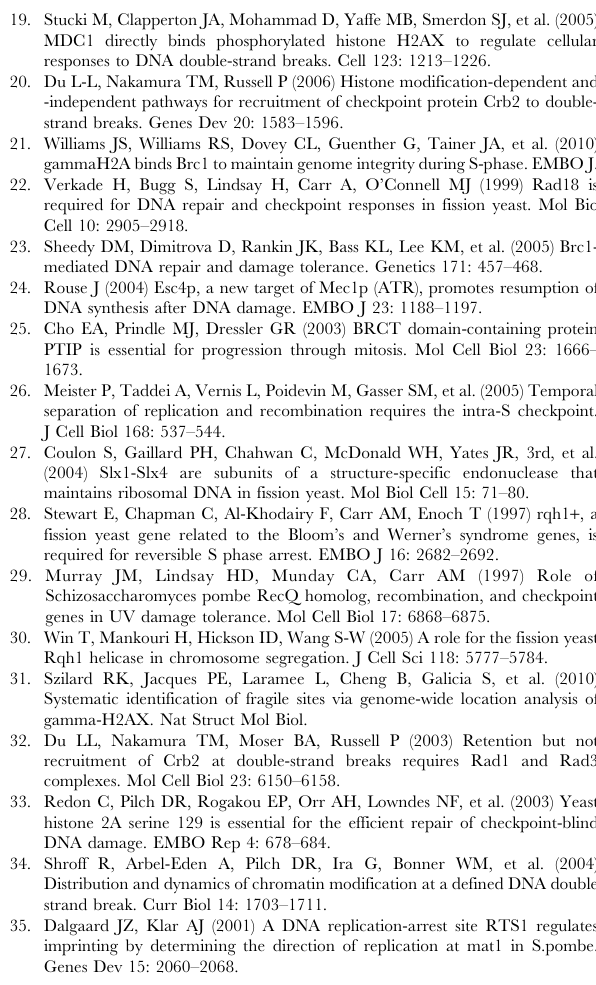
Table S2 S. pombe strains used in this study.